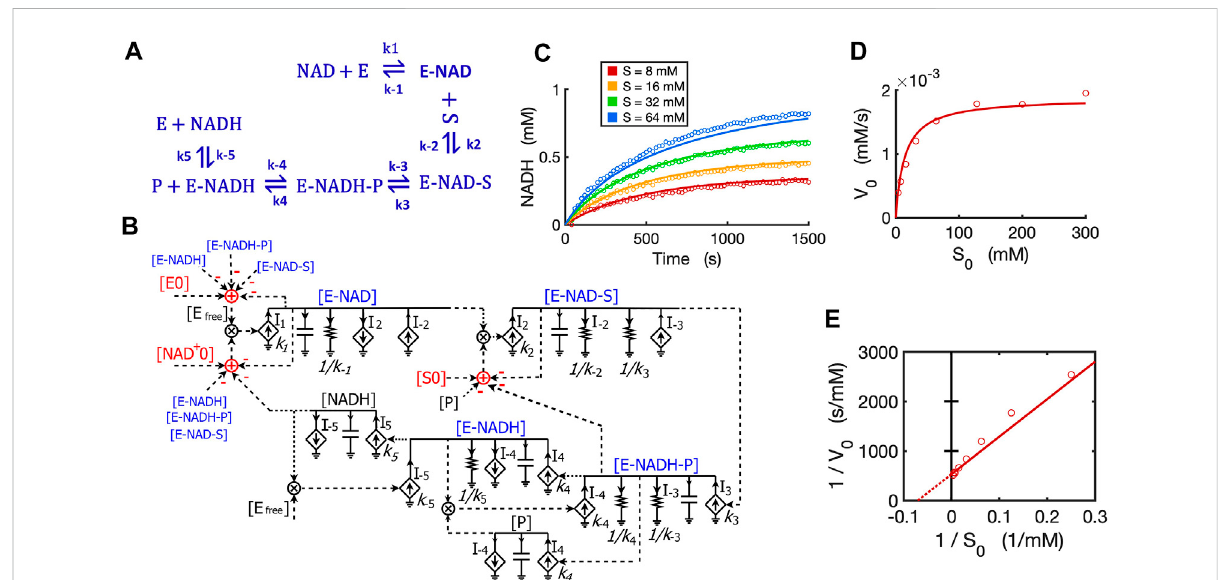
FIGURE 11 Circuitmodelingofareversiblereactioncatalyzedbyyeastalcoholdehydrogenase(ADH). (A) Themechanisticschemefora fi ve-stepreversible reaction foryeast ADH,where EisADHenzyme,S isethanol,and Pistheacetaldehydeproduced. (B) Circuit modelthat exactlymatchesthekinetics of the reaction scheme in (A) . [E 0 ] is the initial ADH concentration (3.9 nM), [NAD 0 + ] is the initial NAD + concentration (4 mM), [S 0 ] is the initial ethanol concentration. Arrows along solid lines or in current generators (diamond symbols) indicate the direction of the corresponding current (reaction fl ux). Voltages or currents labeled with the same names indicate the same values. All circuit symbols are shown in Figures 1, 3. (C) Model curves of product [NADH] dynamics over time fi tted to experimental data points with varying ethanol concentrations. (D) Simulation curves of initial reaction